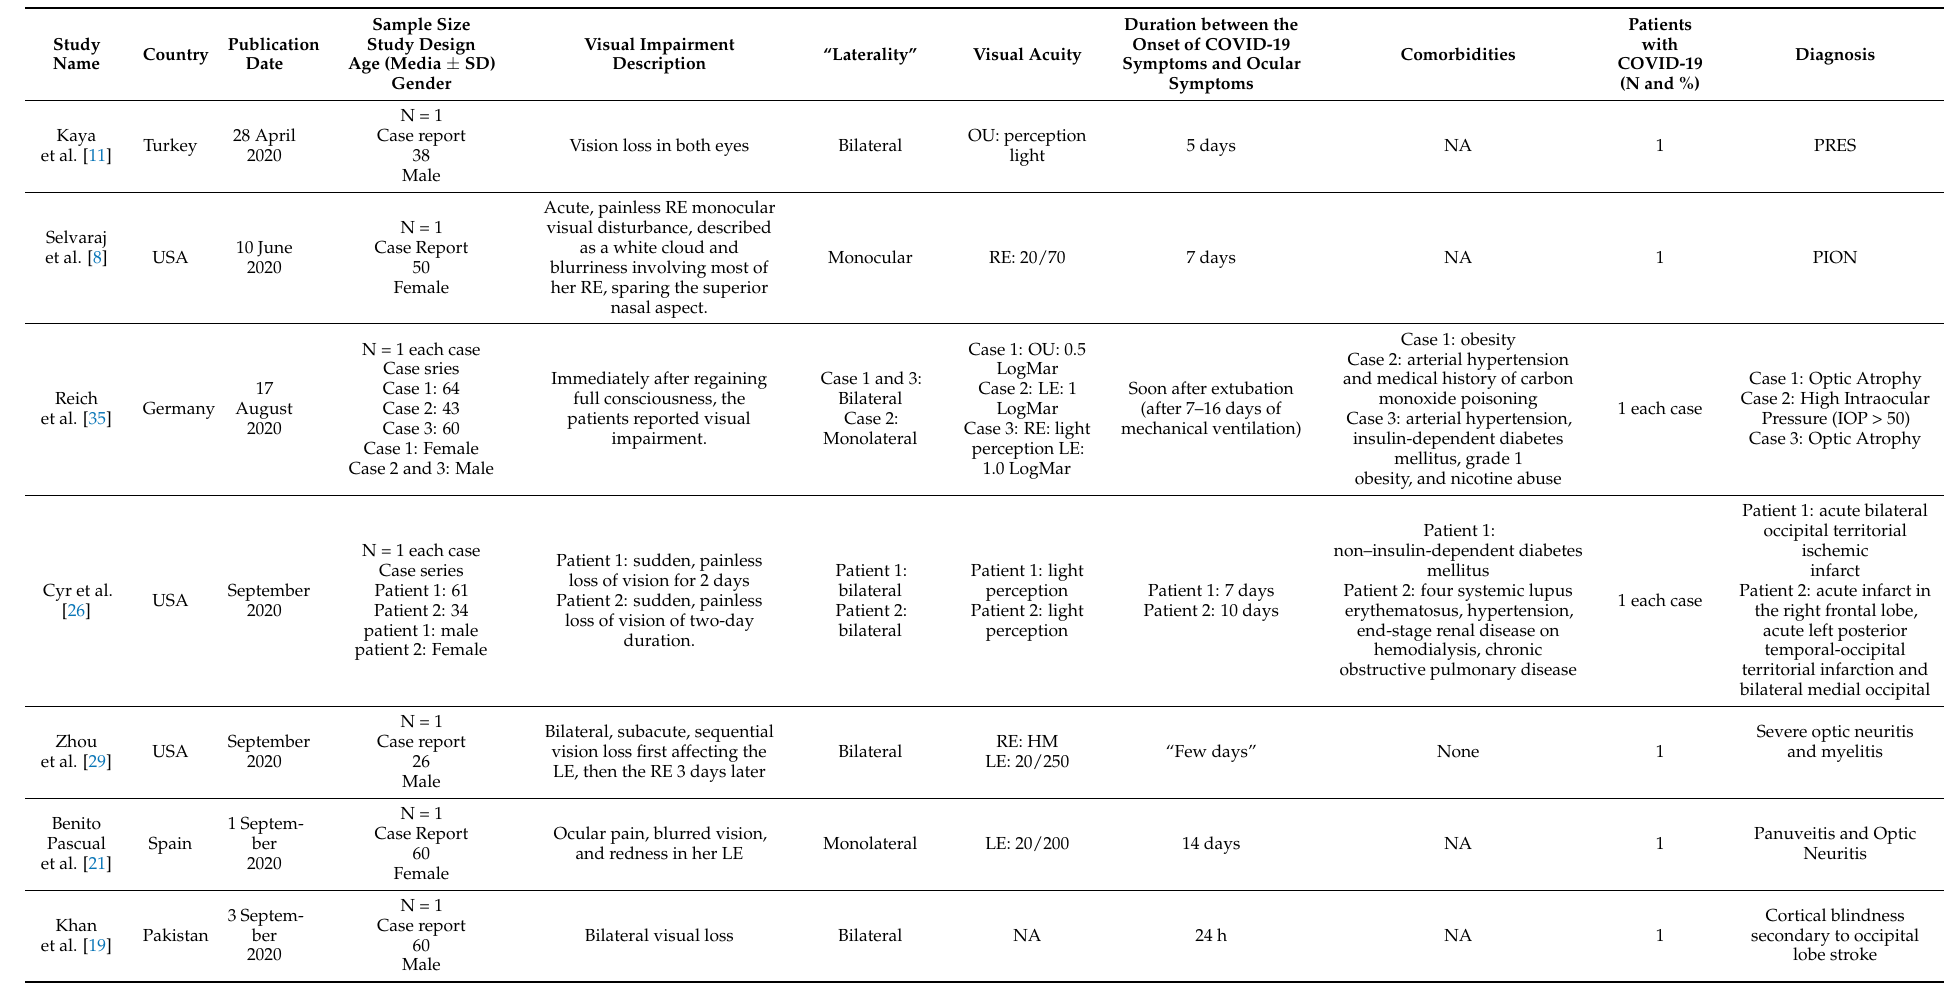
Table 1. Characteristics of studies included in the systematic